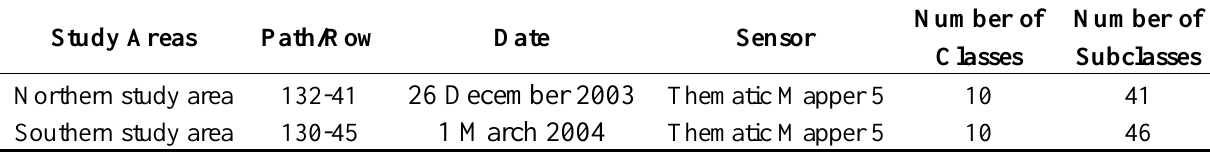
Table 1. Satellite image data and number of training classes and